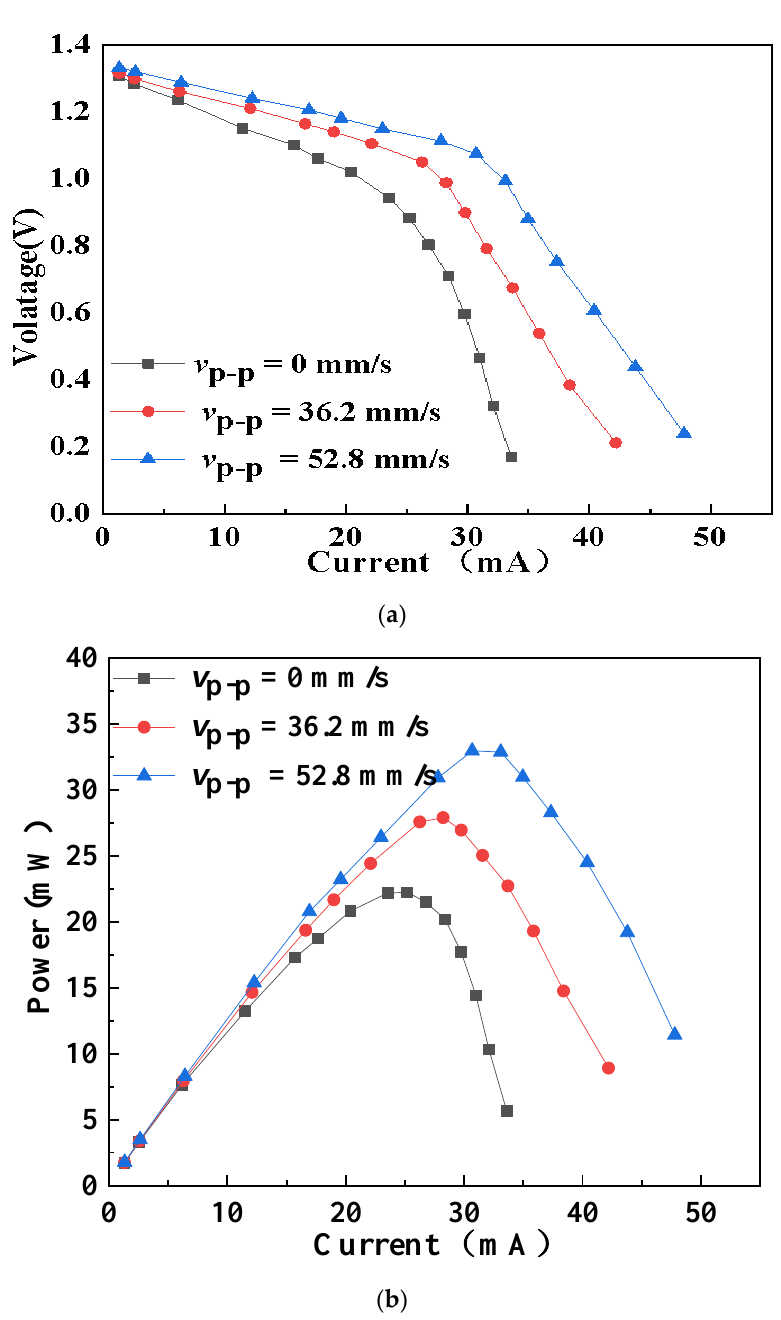
Figure 2. Characteristics of the button zinc–air battery ultrasonically excited under different vibration velocities at 161.2 kHz. ( a ) Voltage vs. current. ( b ) Power vs. current.